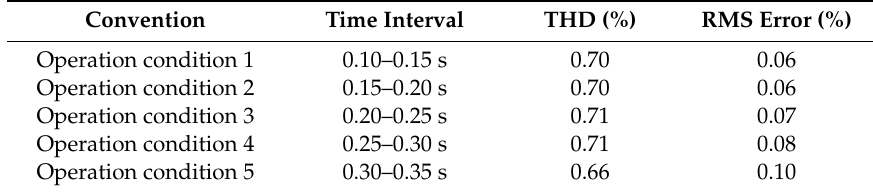
Table 5. Output voltage quality for simulation test 1 (120 V @ 60 Hz).